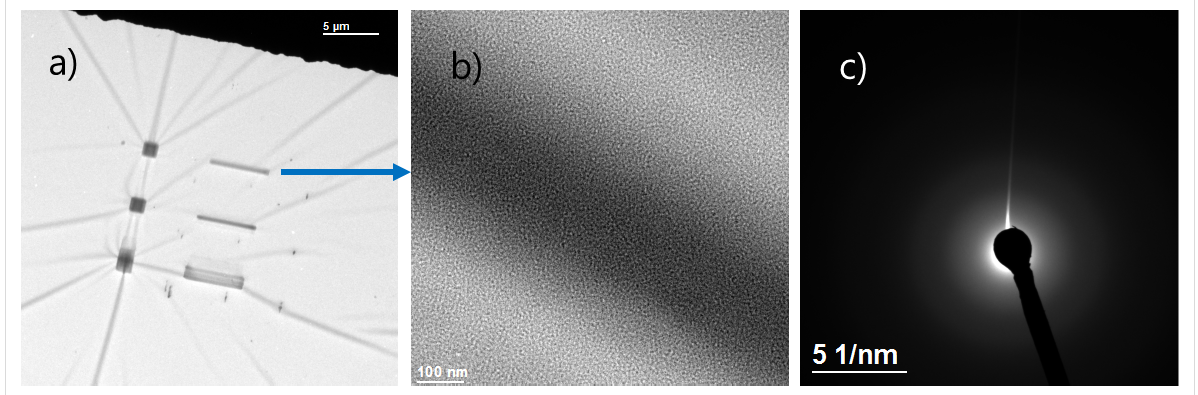
Figure 2: TEM of as-deposited lines and squares from Cu(hfac) 2 on an amorphous carbon membrane on a TEM grid. a) An overview of deposits, b) zoom into a line deposit, c) a SAD pattern showing amorphous nature of the deposit.